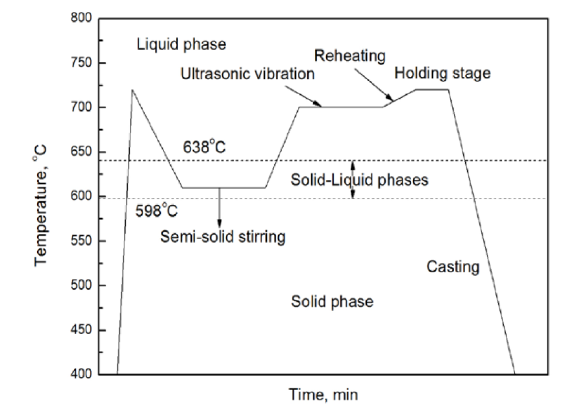
Figure 2: The temperature–time sequence in fabricating composites with the method of stir casting assisted by ultrasonic vibration.